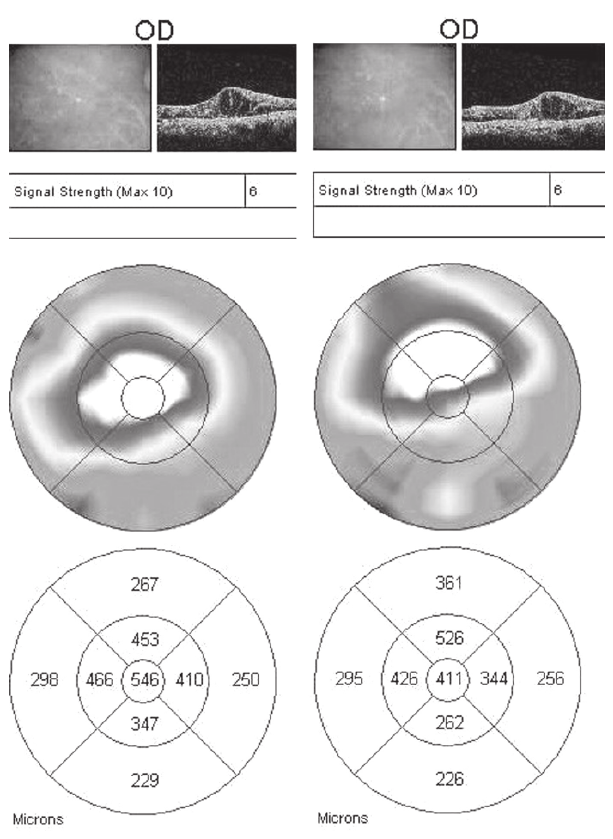
Figure 1 - Fast macular scans of a patient with diffuse diabetic macular edema obtained consecutively. Note the differences in the central macular values between scans.